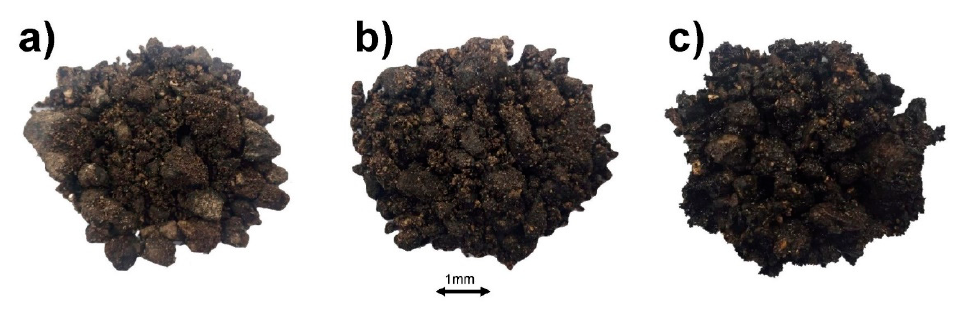
Figure 6. Coating test NLT-196/84 for RAP, BBA, and 3% emulsion with different percentages of precoating water. ( a ) 1% water-to-aggregate. ( b ) 2% water-to-aggregate. ( c ) 3% water-to-aggregate.